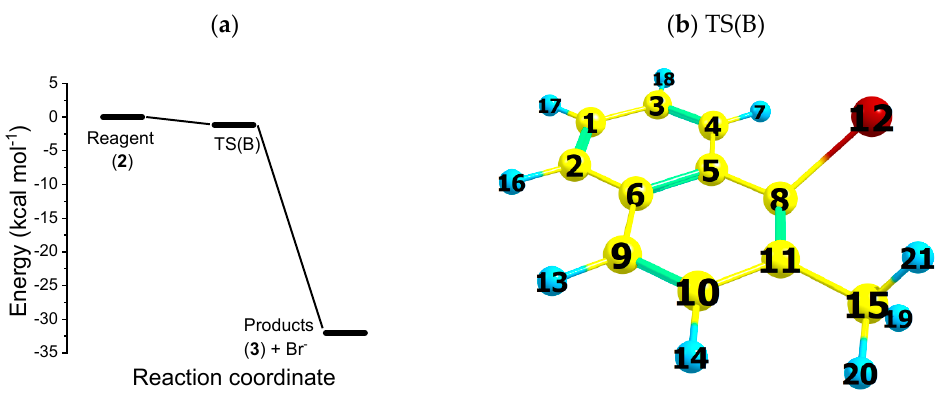
Figure 1. ( a ) Potential energy surface for reaction path B, at the UB3LYP/cc-pVTZ level of theory. Gibbs free energy of reagents ( 2 ), final products (3 + Br − ) and transition state ( TS ( B ) ). ( b ) Bonds used to characterize the bromide dissociation mechanism: C 8 − Br 12 . TS(B) dihedral angle atoms 5 − 11 − 8 − 12 are used to characterize the bromide dissociation mechanism. The energy levels were normalized to the ground state energy of ( 2 ).